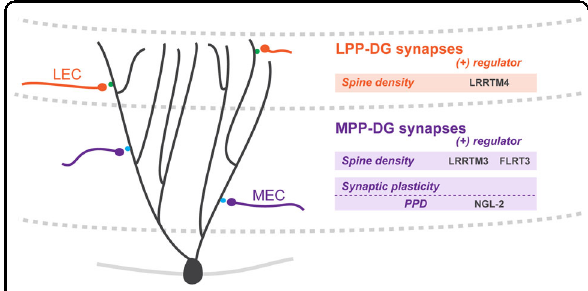
Fig. 2 LRR proteins regulate synapse development in dentate gyrus granule cells. LPP-DG synapses. Lateral perforant path (LPP) axons from layer II (LII) lateral EC (LEC) synapse on distal dentate gyrus (DG) granule cell dendrites in the outer molecular layer (OML). Loss of LRRTM4 results in a reduction in spine density at LPP-DG synapses. MPP-DG synapses. Medial perforant path (MPP) synapses form between incoming LII medial EC (MEC) afferents and DG granule cell dendrites in the middle molecular layer (MML). At MPP-DG synapses, loss of FLRT3 or LRRTM3 results in a reduction in spine density. Loss of NGL-2, or its pre-synaptic binding partner, netrin-G2, results in an increase in the paired-pulse ratio (PPR) that corresponds to an attenuated paired-pulse depression